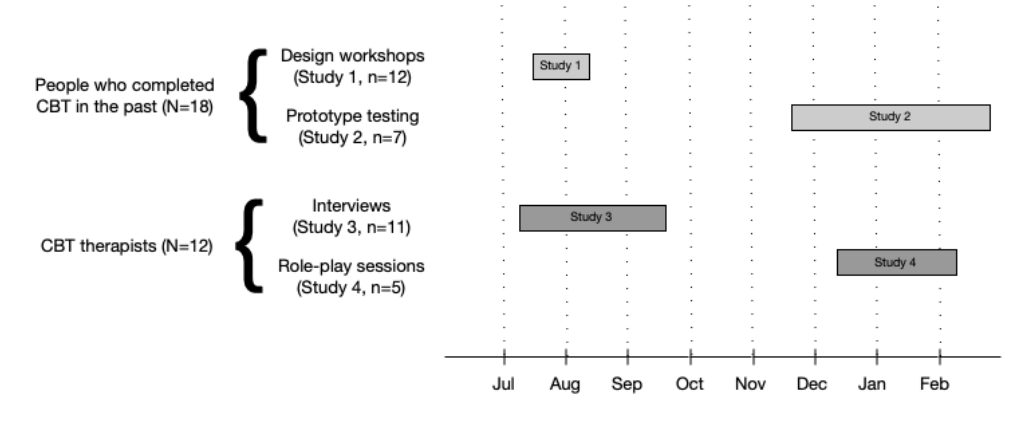
Figure 1. Study flow and number of participants. The period between the studies was dedicated to the analysis of Study 1 and 3 results, and identifying design requirements that informed the prototypes used in Studies 2 and 4. The research took place in